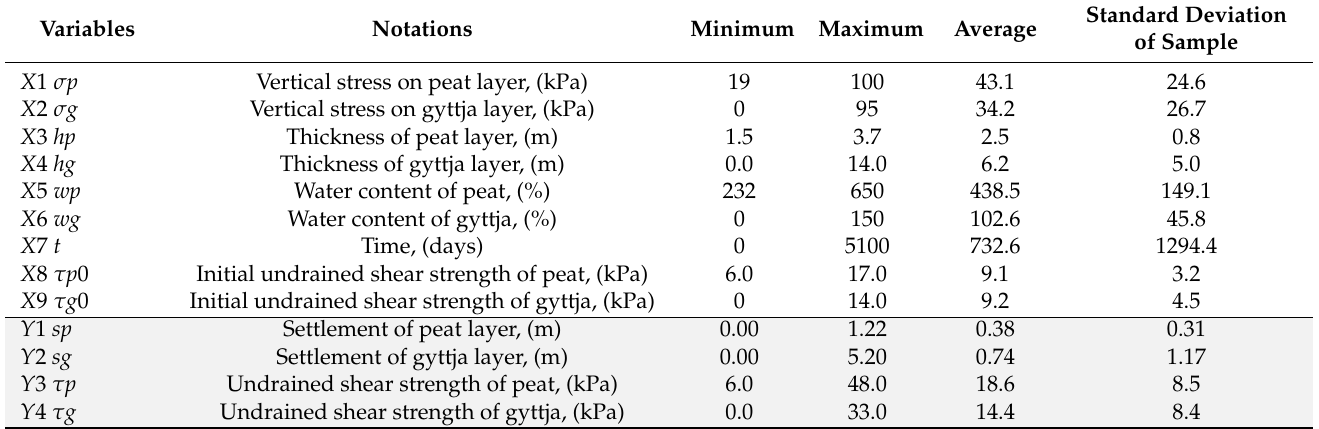
Table 1. Variables analyzed and the statistical specifications of the database.